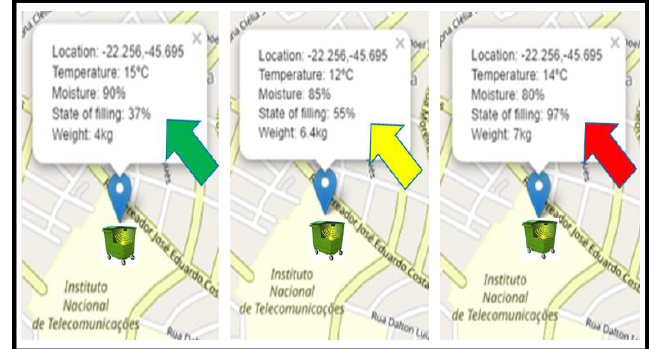
Figure 8. Fill variation presented by My Waste App.